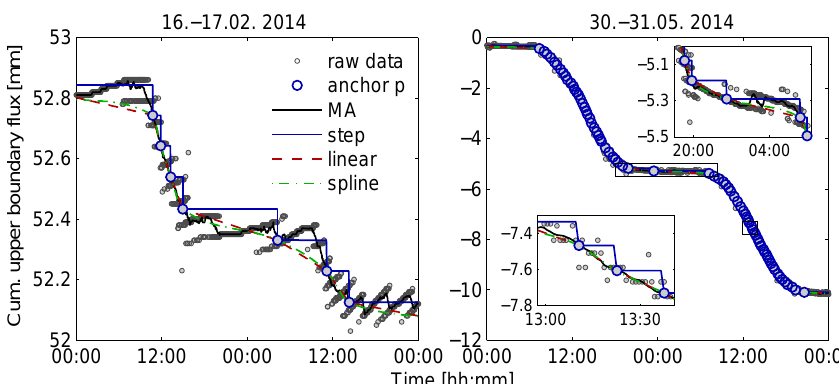
Figure 2. Raw data of two evapotranspiration events, filtered with the original AWAT filter (steps) and linear as well as spline interpolation schemes. Left: low evapotranspiration on 16–17 February 2014; right: high evapotranspiration rates on 30–31 May